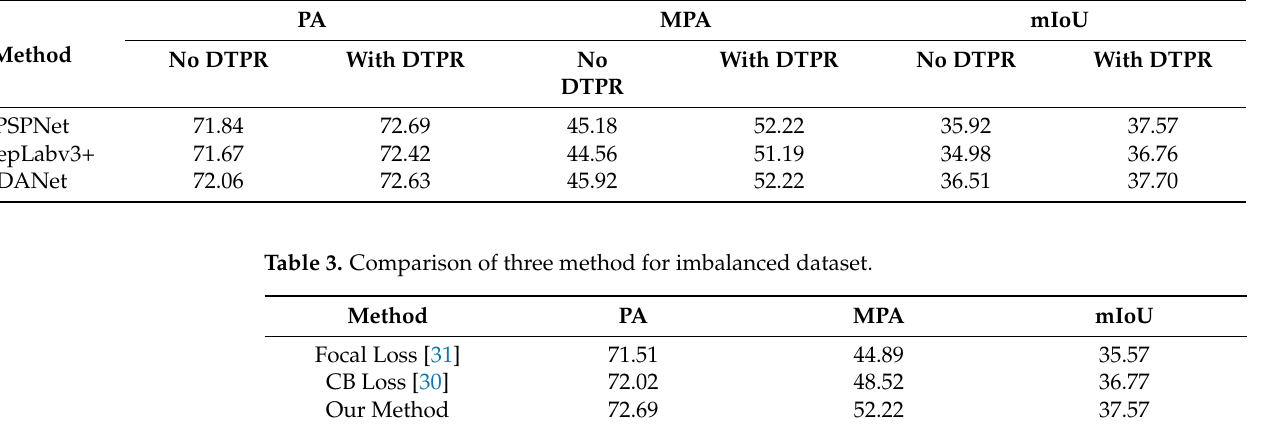
Table 2. Comparison of three SOTA models on the MHPv2.0 validation set.